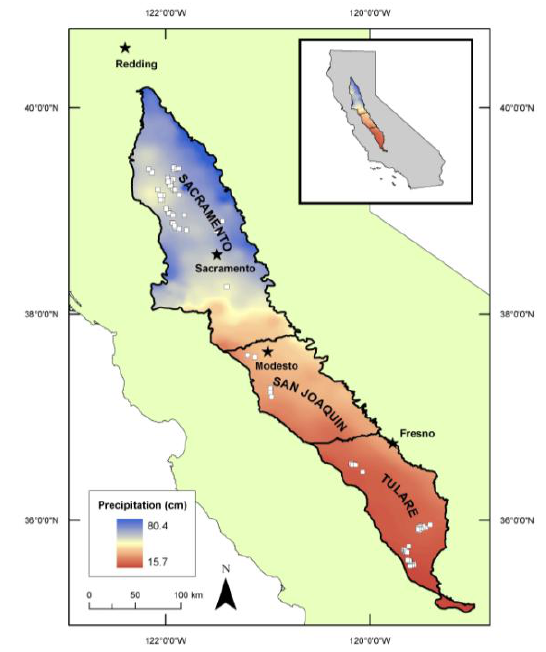
Figure 1. Location of 2008 and 2009 sampling sites (squares) in California’s Central Valley. For this study, the California’s Central Valley (CCV) was divided into three major sub-basins; Sacramento; San Joaquin and Tulare. Gradient in estimated average annual precipitation (1971–2000) is illustrated with color, with red being driest and blue wettest (PRISM Climate Group